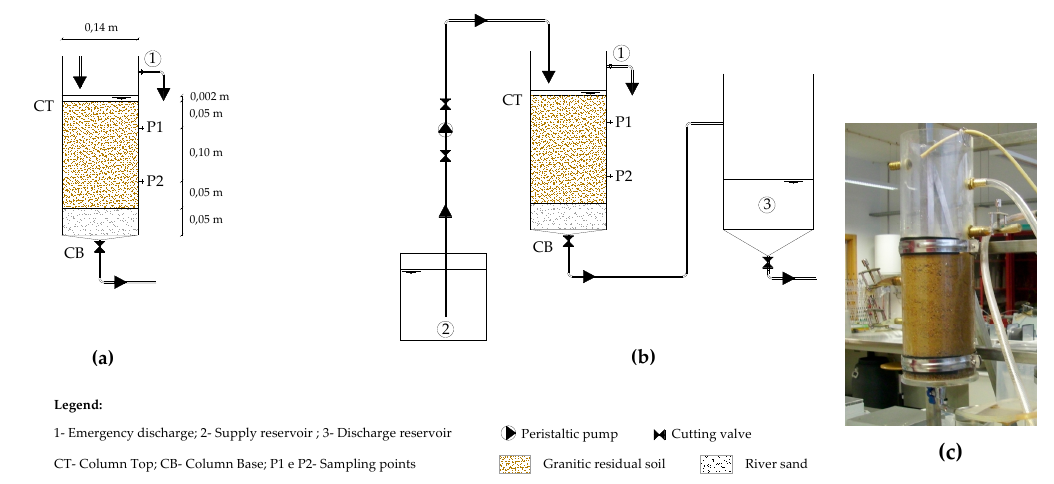
Figure 1. Scheme of the column tests: ( a ) discontinuous (fed-batch) mode; ( b ) continuous mode; ( c ) column in